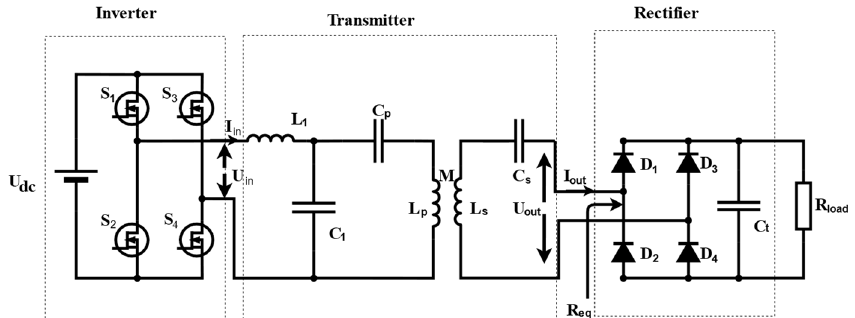
Figure 1. Block diagram of LCCL-S WPT system.